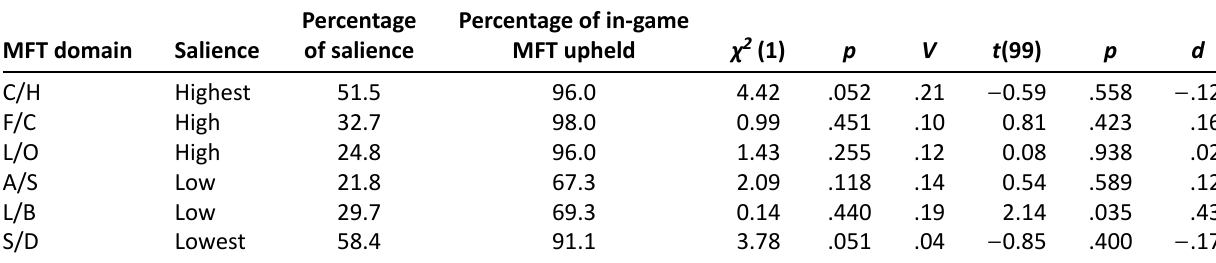
Table 4. MFT salience with in-game moral choice and